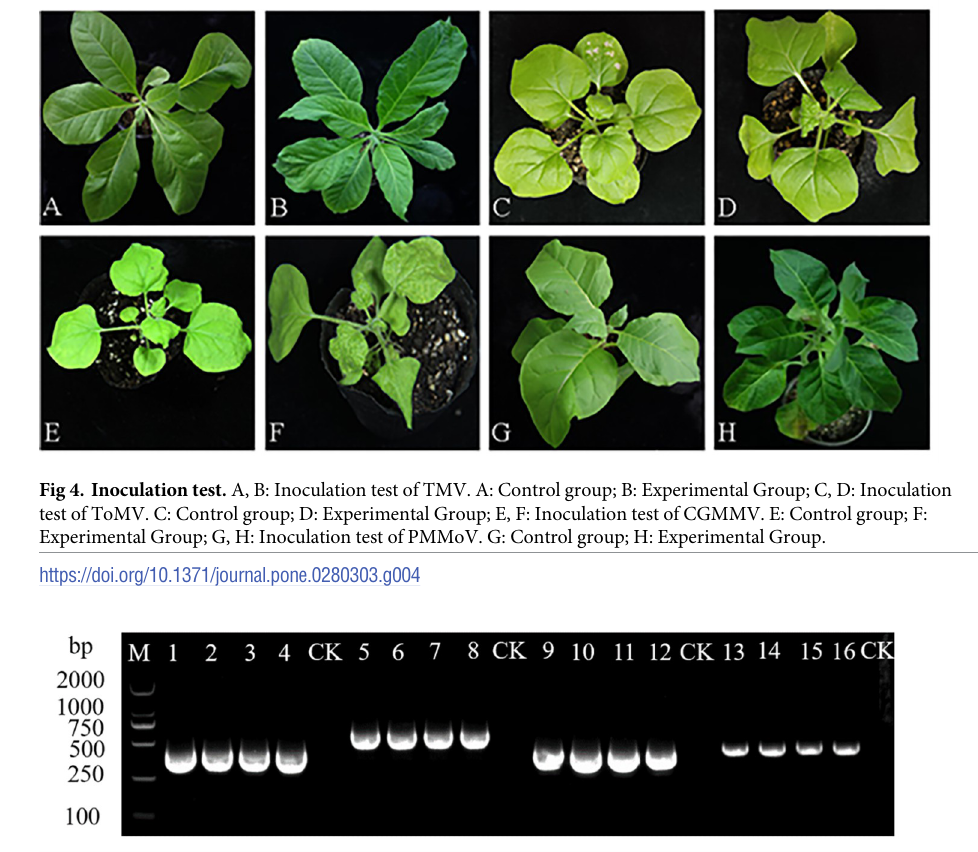
Fig 5. RT-PCR test results of inoculated tobacco. M: Trans2K 1 DNA marker; CK: Negative control; 1–4: Tobacco samples inoculated with TMV concentrate; 5–8: Tobacco samples inoculated with ToMV concentrate; 9–12: Tobacco samples inoculated with CGMMV concentrate; 13–16: Tobacco samples inoculated with PMMoV concentrate.